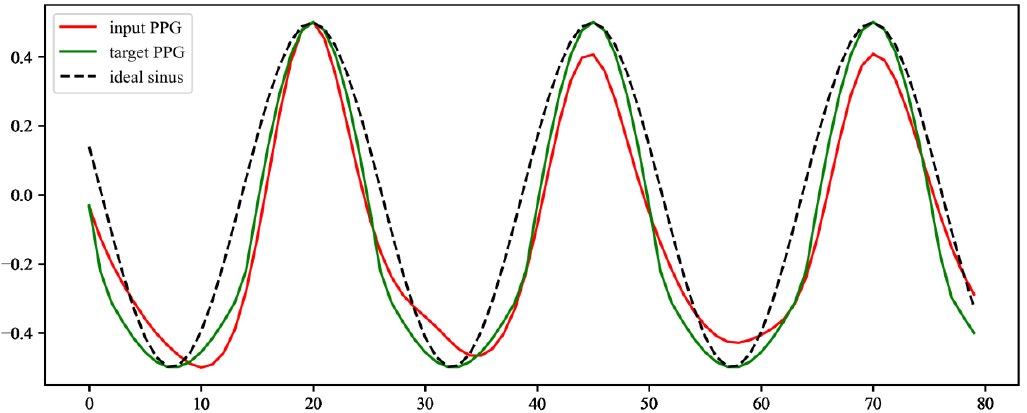
Figure 5. Correction of ideal target sinusoidal waveform to resemble real PPG signal. The target waveform is calculated from the ideal sinusoidal waveform (ideal sinus) according to Equation (6) and normalised (target PPG). In this simple way, the target PPG better resembles the real PPG signal (input PPG).